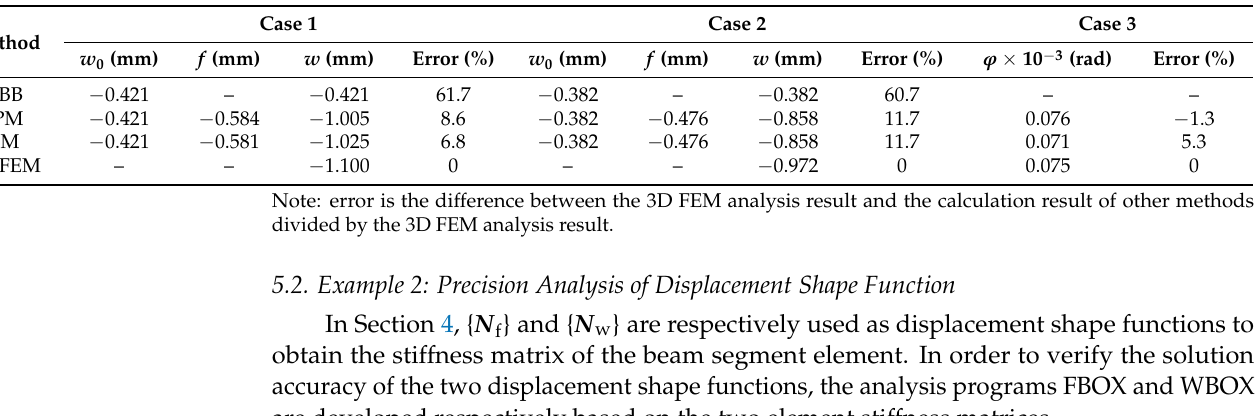
Table 2. Displacement results of the mid-span cross-section.